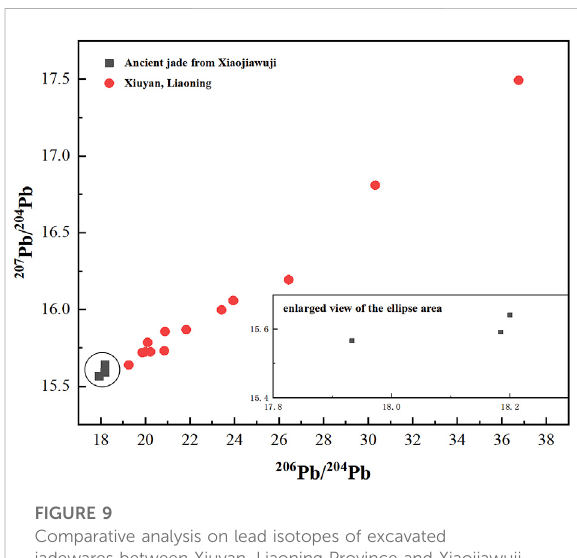
FIGURE 9 Comparative analysis on lead isotopes of excavated jadewares between Xiuyan, Liaoning Province and Xiaojiawuji, Hubei